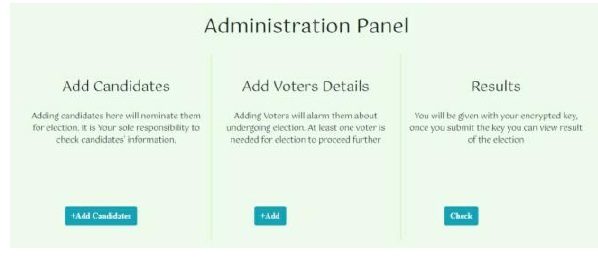
Figure 3. Home page . Figure 4. Admin panel.